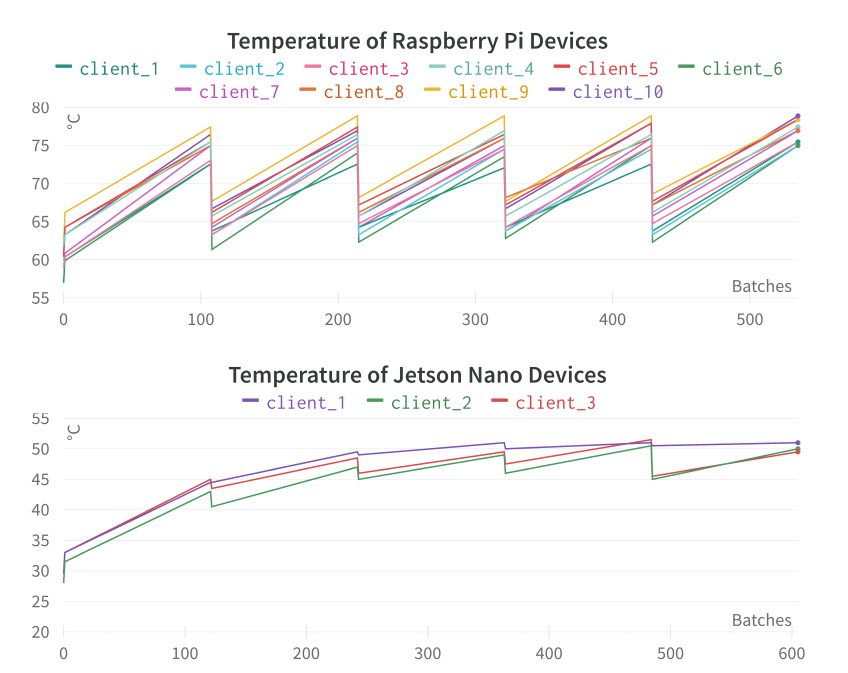
Figure 15. Temperature comparison for different Raspberry Pi and Jetson Nano devices. The x-axis represents the incremental number of training mini-batches, the y-axis represents temperature in Celsius ( ◦